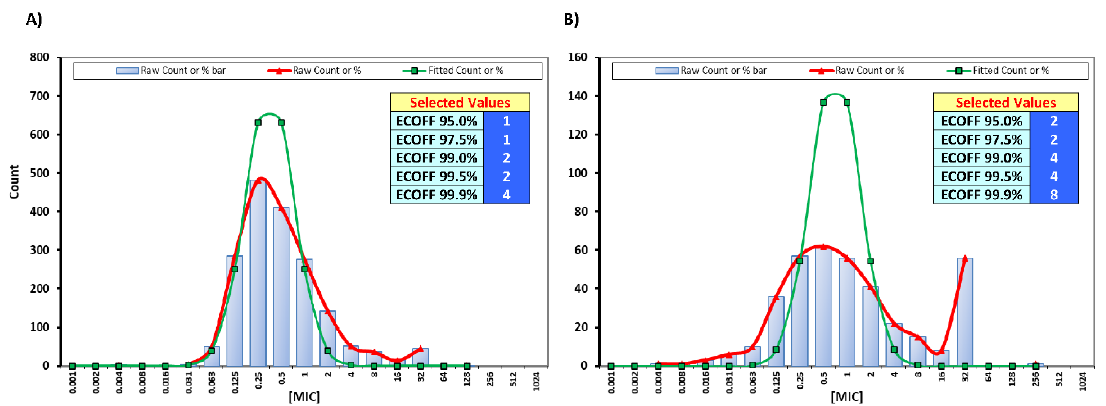
Figure 4. Estimation of wild-type MIC distributions for moxifloxacin against ( A ) Gram-positive and ( B ) Gram-negative bacteria.